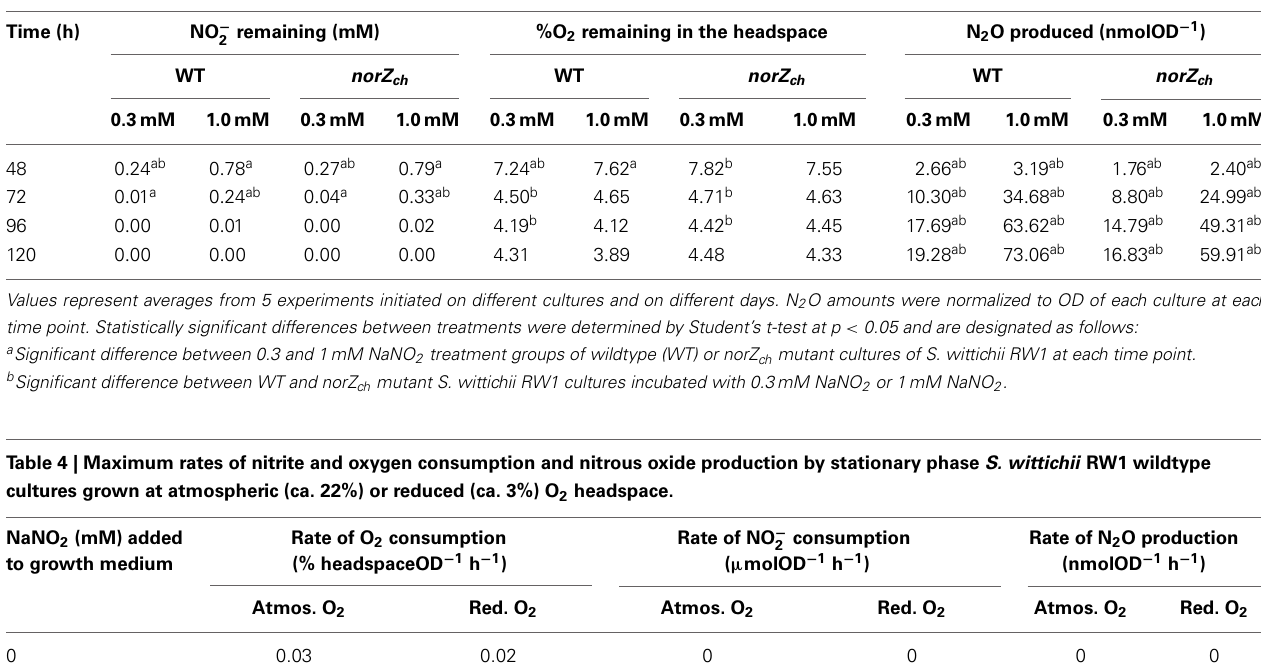
Table 3 | Consumption of nitrite and oxygen and production of nitrous oxide by wild-type and norZ ch mutant cultures of S. wittichii RW1 initiated at atmospheric oxygen headspace and with 0.3 or 1mM NaNO 2 .